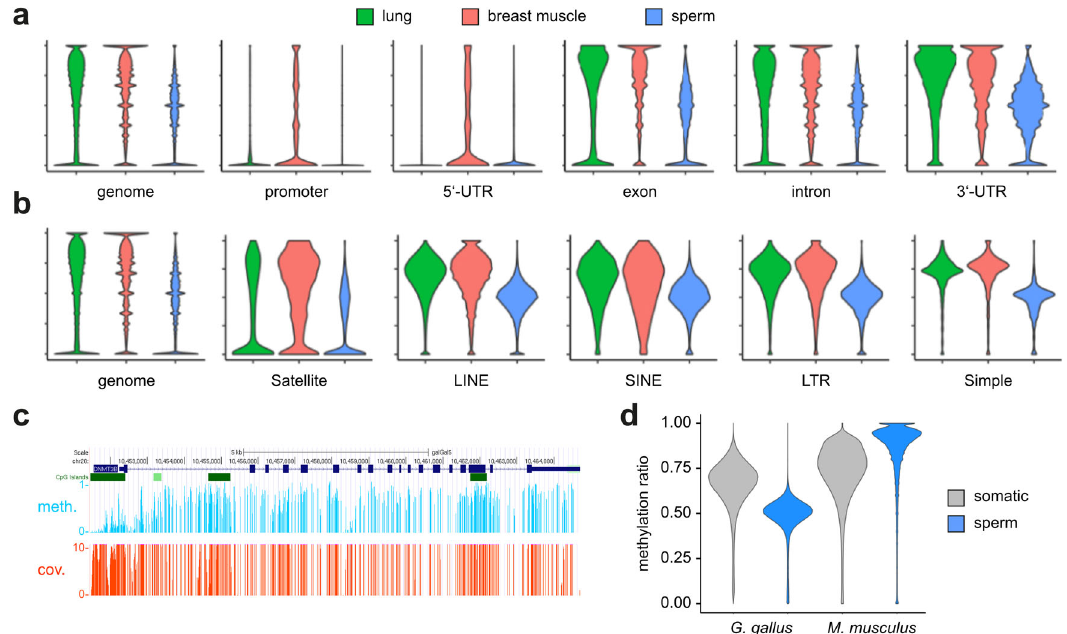
Fig. 2 Methylation analysis of genomic features. a Violin plots showing methylation levels of different genomic features in three different tissues. All differences between tissues are statistically signi fi cant (P = 2.2 × 10 − 16 , Wilcoxon rank sum test), except the difference between lung and breast muscle at 3 ’ -UTRs. b Violin plots showing methylation levels of different repeat classes in three different tissues. c Representative gene body methylation pattern. The methylation track shows DNA methylation levels (light blue) and sequencing coverage levels (red) for all CpGs of the chicken DNMT3B locus (chromosome 20) in lung. Sequencing coverages were cut off at >10. d Violin plots showing methylation ratios of 2 kb sliding windows. Representative somatic datasets are from chicken lung and mouse methylomes (Fig. 2d). This contrasts the sperm DNA hyper- methylation in mammals 32 (Fig. 2d) and may be related to the absence of DNMT3L in chicken (see discussion). Taken together, these fi ndings provide a fi rst indication that DNA methylation in chicken is tissue-speci fi c.